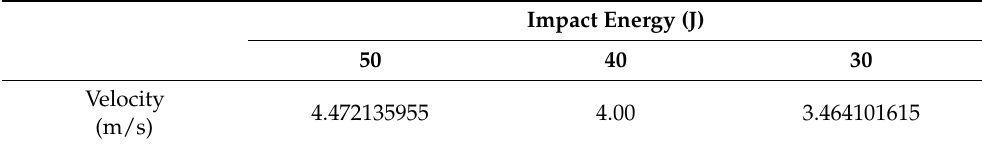
Table 7. Impactor velocities for different impact energies.